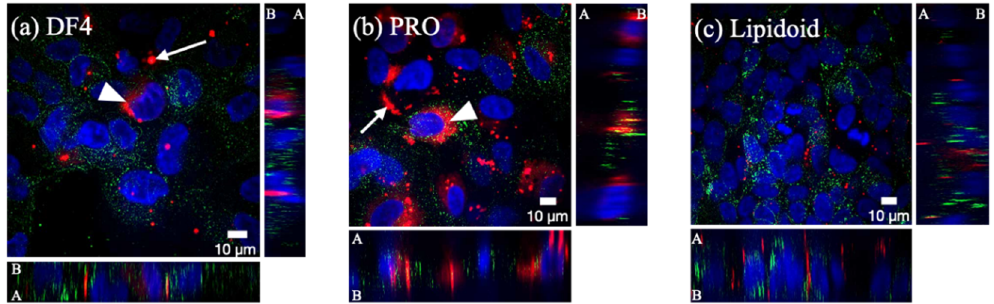
Figure 8. Intracellular distribution of ATTO565-labelled dsDNA (in red) in the 2-week matured hESC-RPE. dsDNA (50 nM) was incorporated into the commercial carriers DF4 ( a ) and Metafectene PRO ( b ), and into lipidoids ( c ). Lysosomes were labelled with CellLight Lysosomes-GFP (in green). Cell nuclei (in blue) were labelled with DAPI. A: apical side; B: basolateral side. Scale bar: 10 µm.